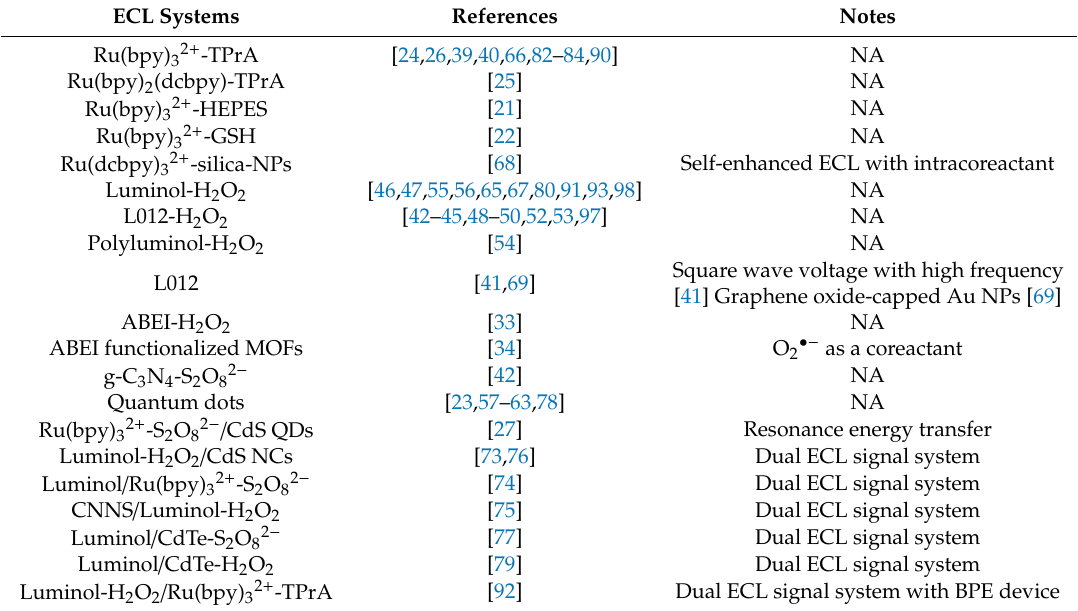
Table 3. Types of ECL